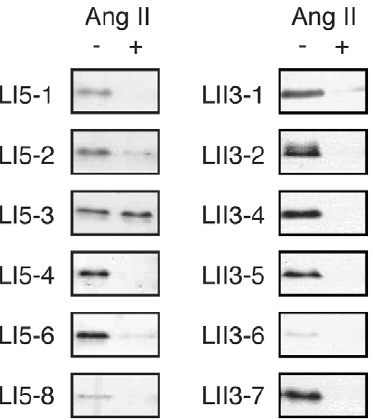
Figure 7. Competitive binding assays. Selected streptavidin-fused peptides were incubated with the hAT1R/CHO-K1 cells in the presence ( + ) ortheabsence( 2 ) of thefreeAng II peptide (100 nM)asa competitor. For details, see the legend of Figure 6 and MATERIALS AND METHODS.